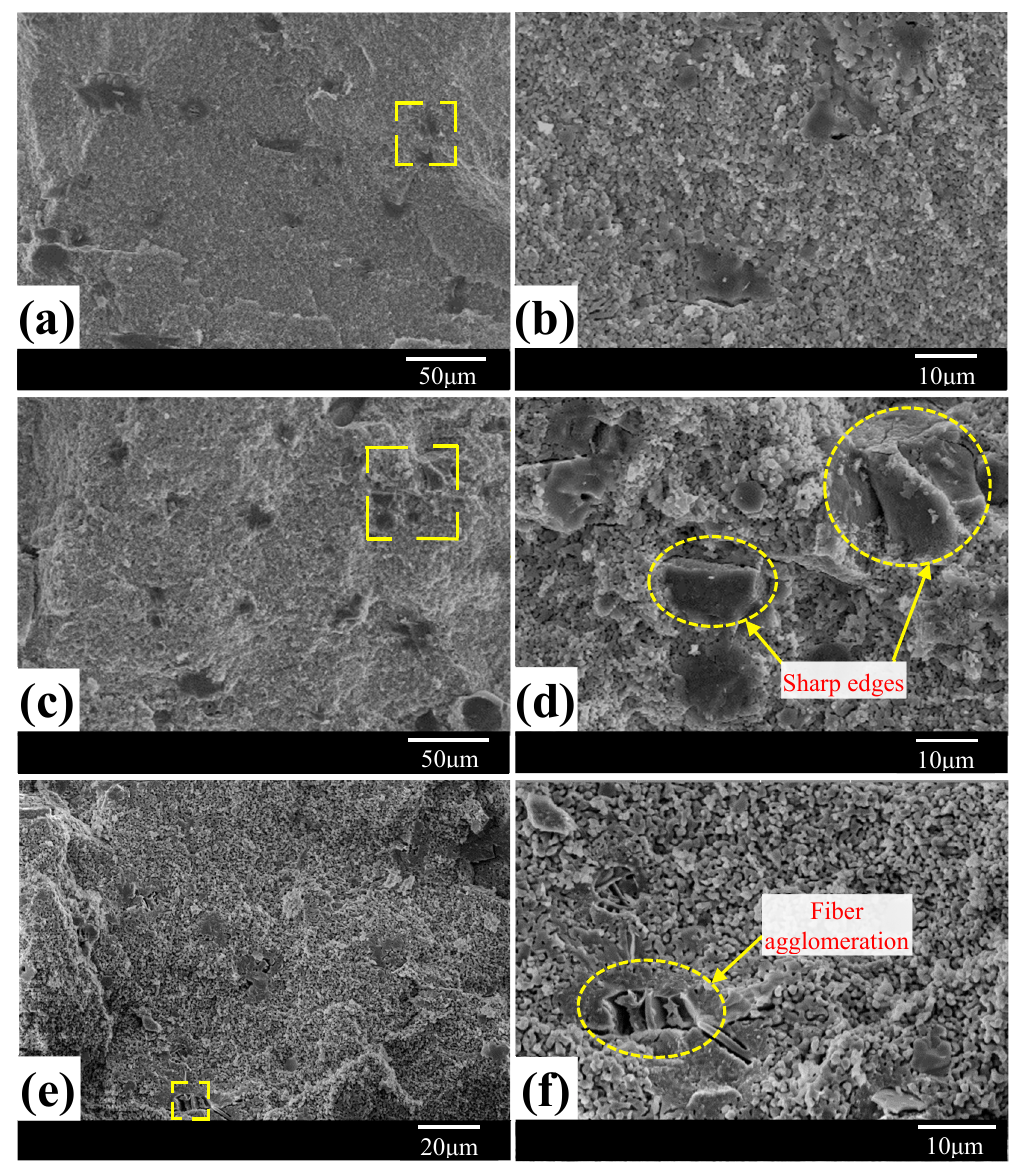
Figure 3. SEM images of MF/HA composites with various MF contents at 1150 °C sintering: ( a , b ) 5 wt%; ( c , d ) 10 wt%; and ( e , f ) 15 wt%.